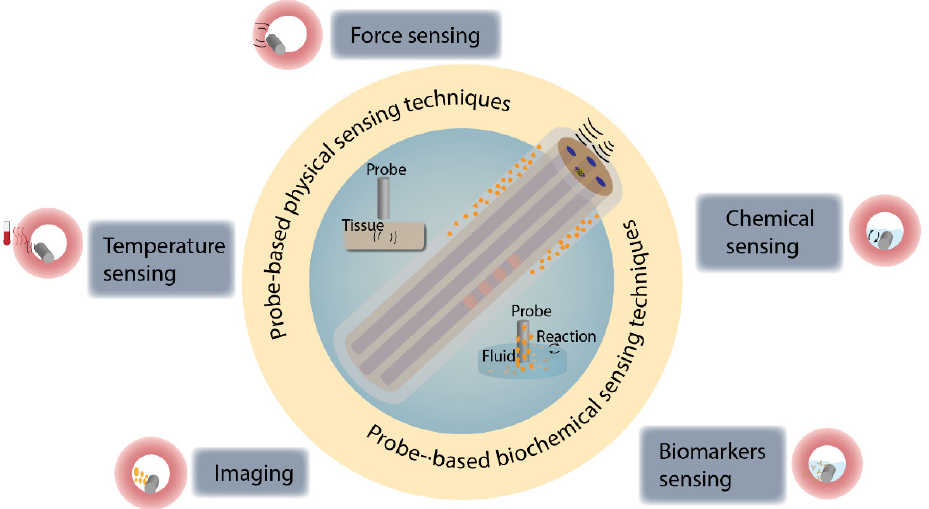
Figure 2. Overview of probe-based sensing techniques for in vivo diagnosis. Various probe-based sensors have been developed to detect physical and biochemical signals in vivo.